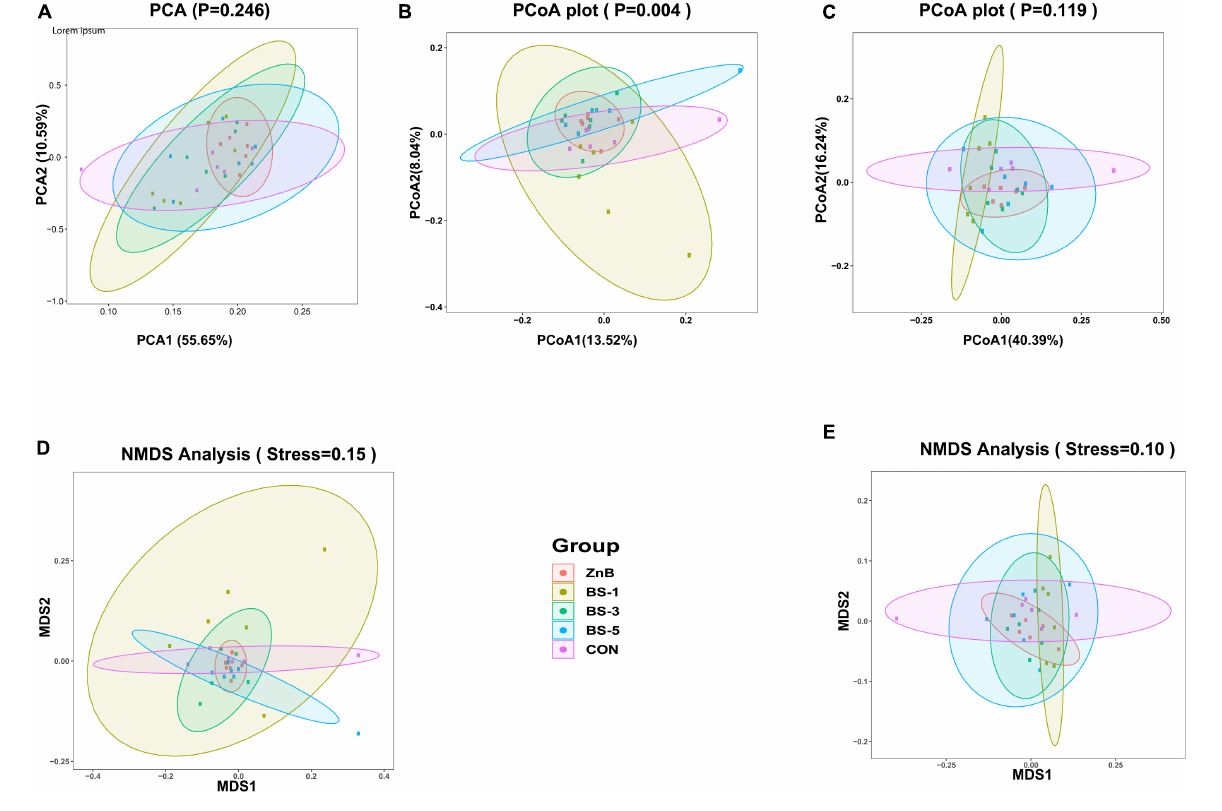
FIGURE 2 | Effect of dietary supplementation of Bacillus subtilis ATCC19659 on cecal microbiota communities of broilers by beta diversity measures. PCA (A) , weighted PCoA (B) , unweighted PCoA (C) , weighted NMDS (D) , and unweighted NMDS (E) . CON, chicks were fed a corn-and soybean-based diet; ZnB,